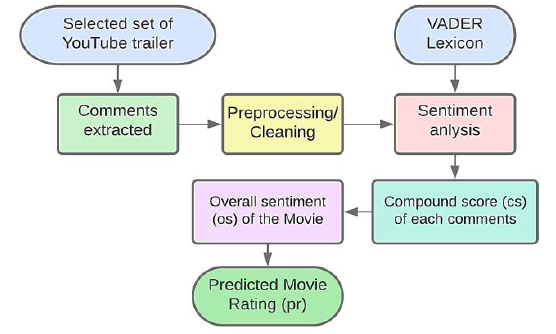
Figure 2. Framework of review data analysis.